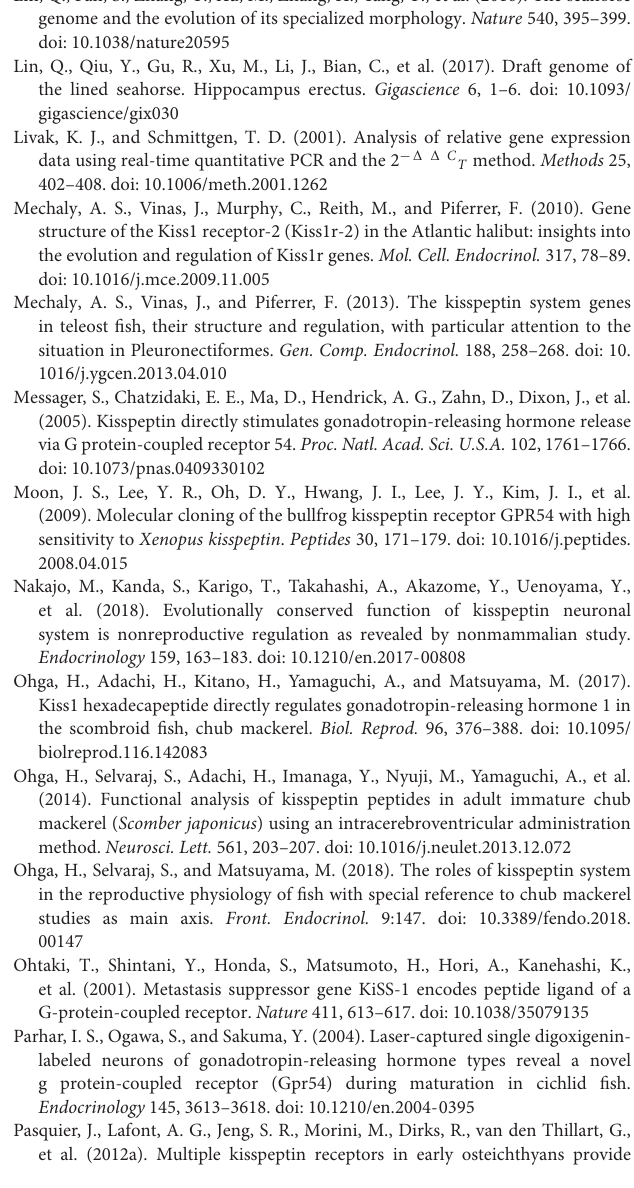
FIGURE S1 | RT-PCR analysis of tissue expression patterns of kiss2 and GPR54-2 in male and female seahorses. Amplification of β -actin was used as house-keeping gene control. Br, brain; Li, liver; Gi, gill; In, intestine; Ki, kidney; Mu, muscle; Po, pouch; Sk, skin; Go, gonad; NC, negative